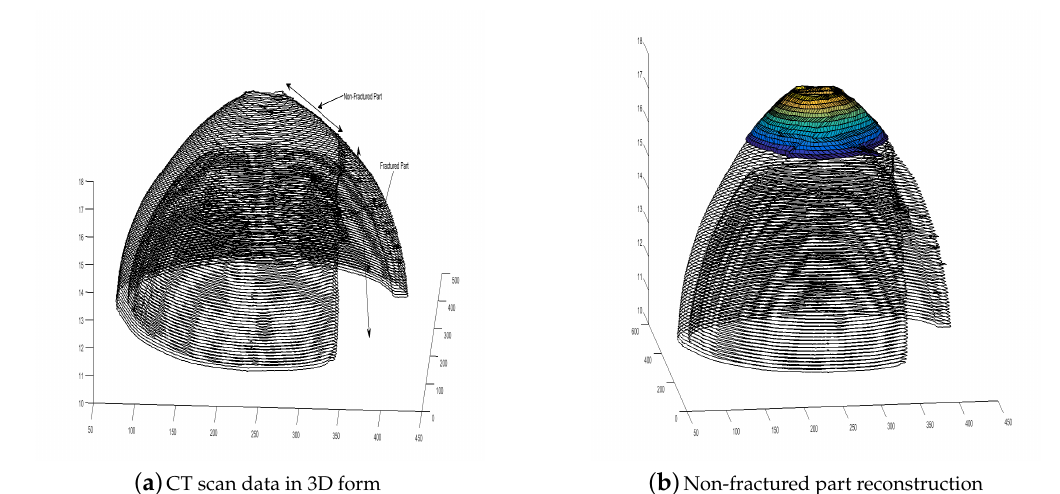
Figure 4. Validity of the proposed